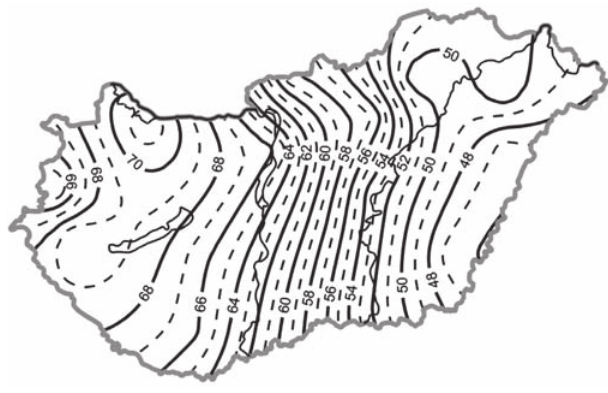
Figure 4 – Mean values of the coeffi cients of variation (CV) of absolute temperature minima in spring measured at 16 stations over a period of